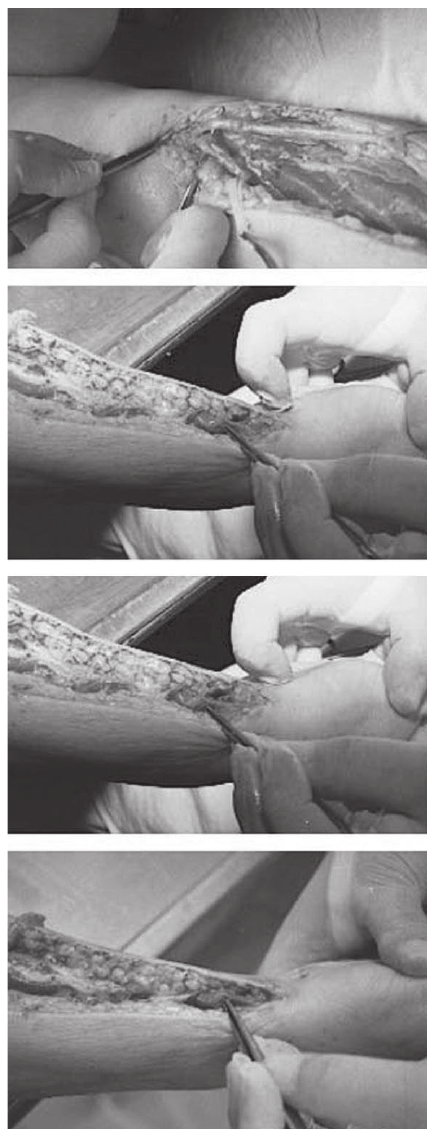
Fig. 1 - Retirada da artéria radial. Identificação da artéria palmar superficial. Normalmente na altura do punho vai formar o arco palmar na mão. É o limite distal da artéria